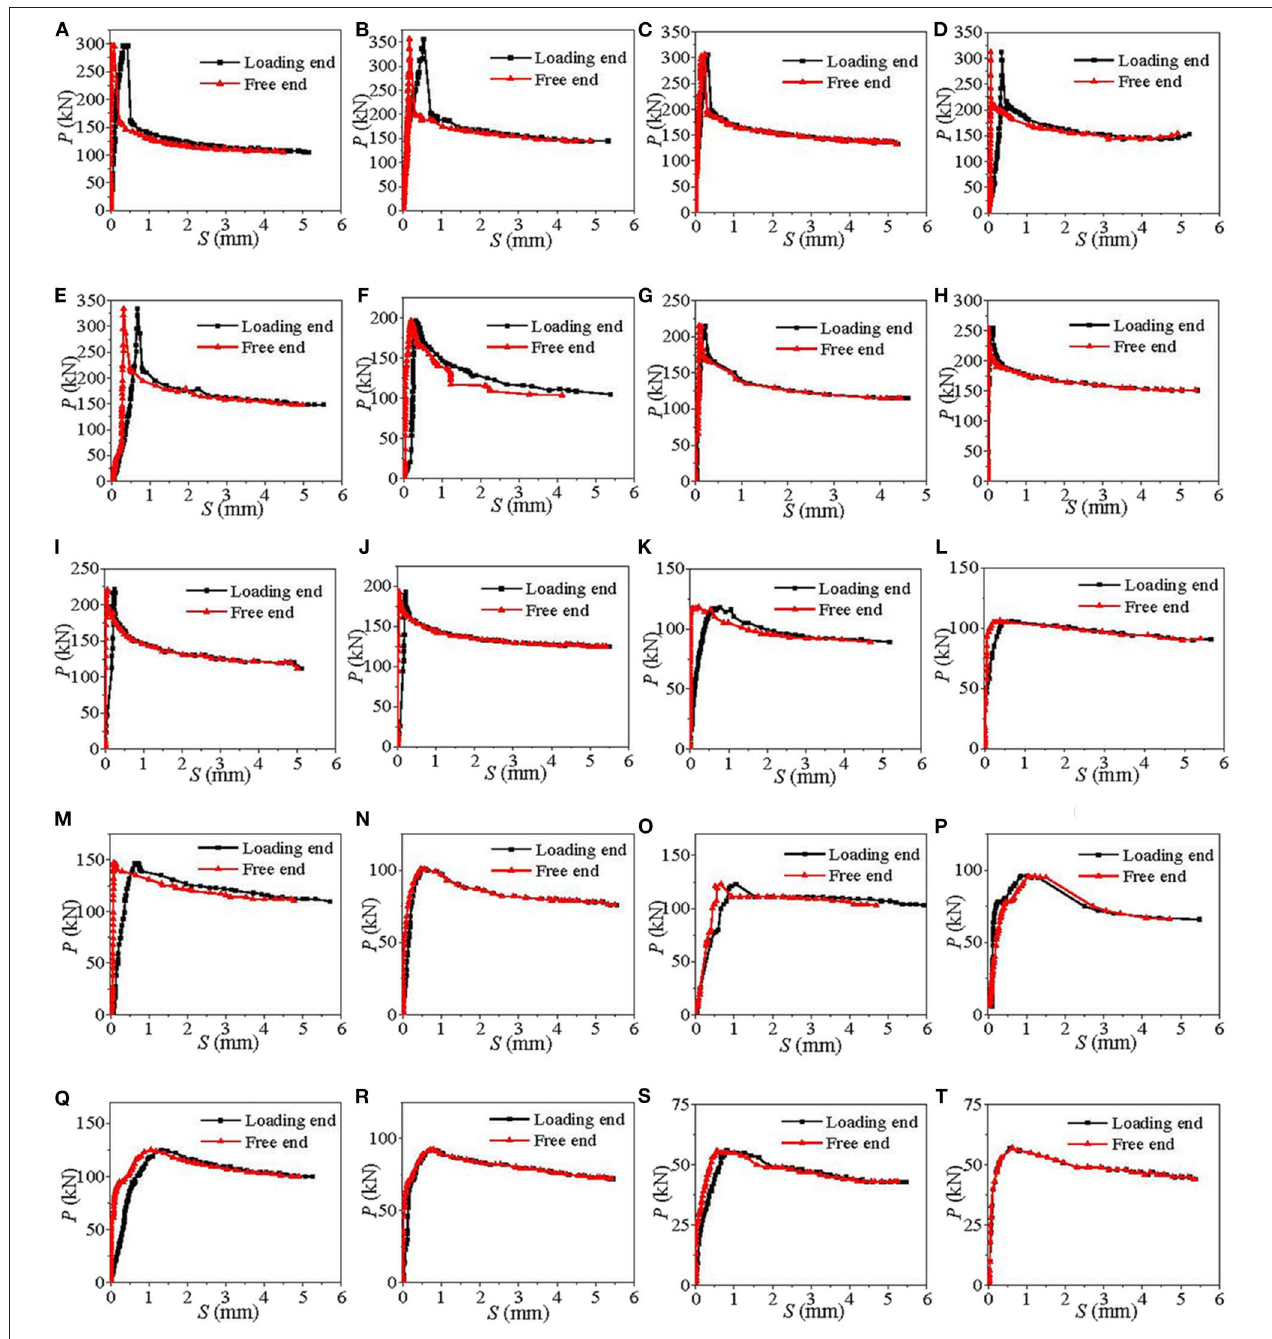
FIGURE 7 | P-S curves of specimens: (A) SRRAC-1; (B) SRRAC-2; (C) SRRAC-3; (D) SRRAC-4; (E) SRRAC-5; (F) SRRAC-6; (G) SRRAC-7; (H) SRRAC-8; (I) SRRAC-9; (J) SRRAC-10; (K) SRRAC-11; (L) SRRAC-12; (M) SRRAC-13; (N) SRRAC-14; (O) SRRAC-15; (P) SRRAC-16; (Q) SRRAC-17; (R) SRRAC-18; (S) SRRAC-19; (T)